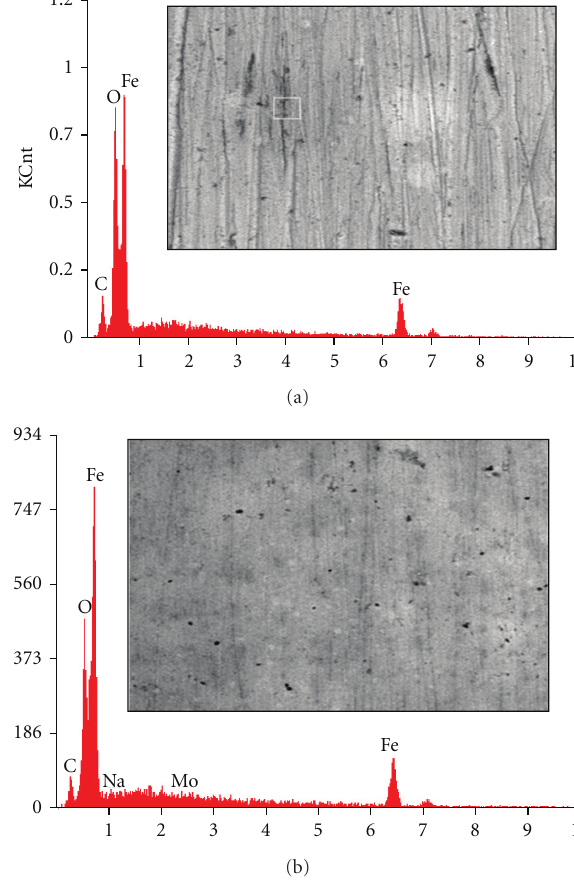
Figure 10: SEM and EDS for CS exposed to RO water without corrosion